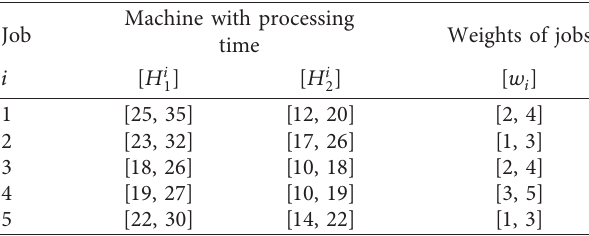
Table 4: Two machines FS problem.